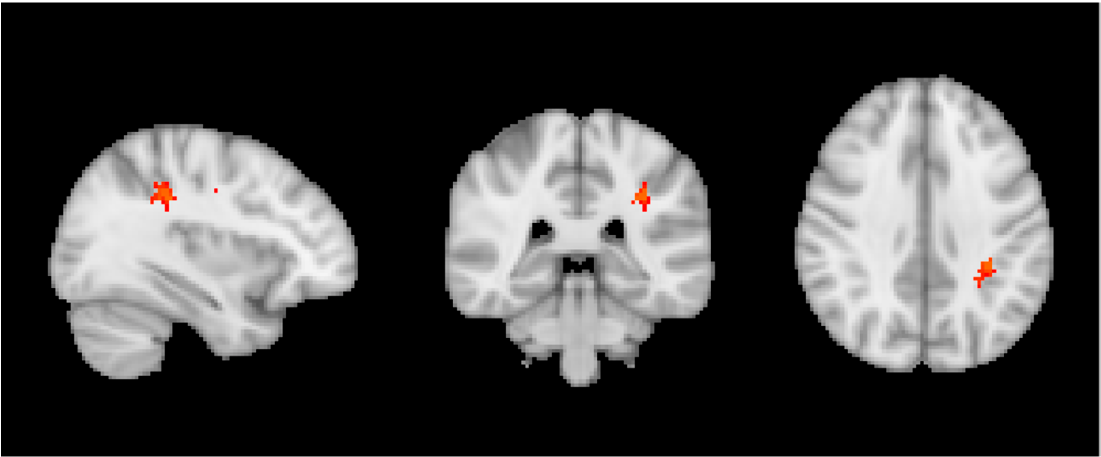
Figure 2. Positive correlation between wine and ASL for only sCON individuals. p < 0.05 TFCE corrected.